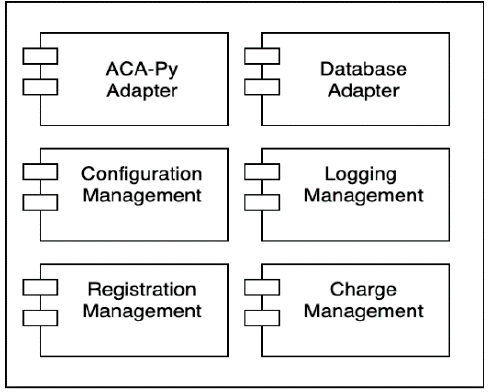
Figure 19. The CS software modules.